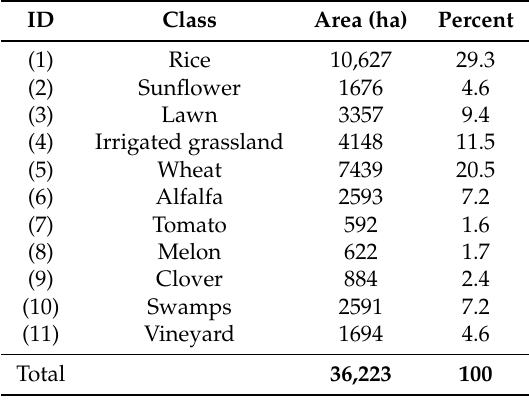
Table 3. The distribution of the agricultural land cover class in